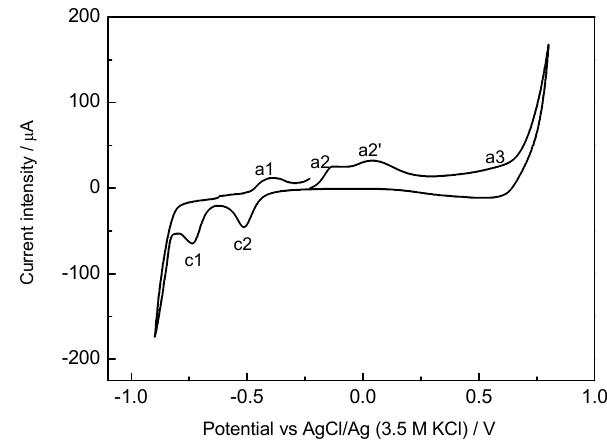
Figure 1. Cyclic voltammogram of the electrochemical response of the Cu rod electrode in 0.1 M NaOH. First scan recorded. Scan rate 10 mV s − 1 .